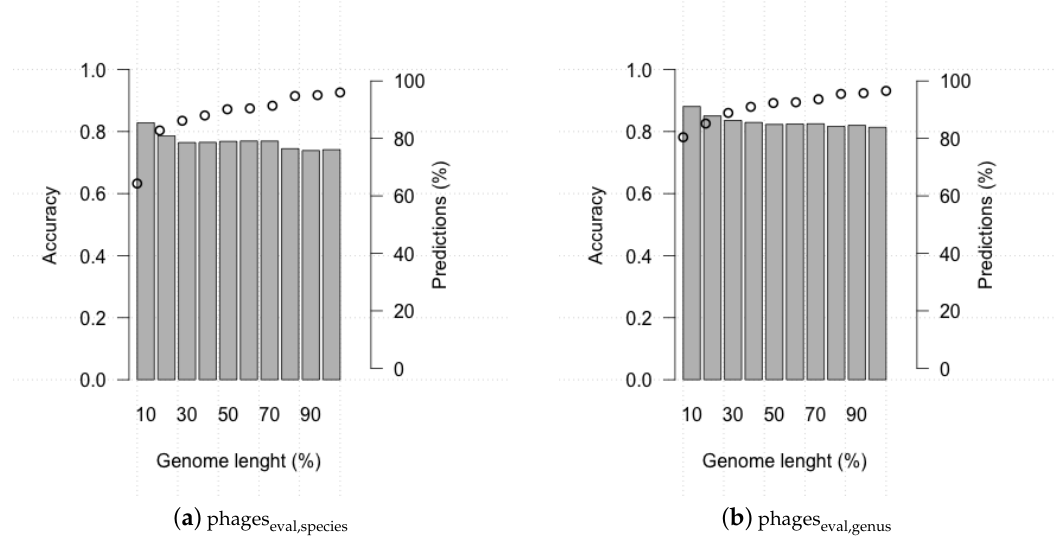
Figure 5. HostPhinder’s accuracy (bar) and percentages of predictions (dots) on phages percentages of genome length from 10% to 100% of total genome length.